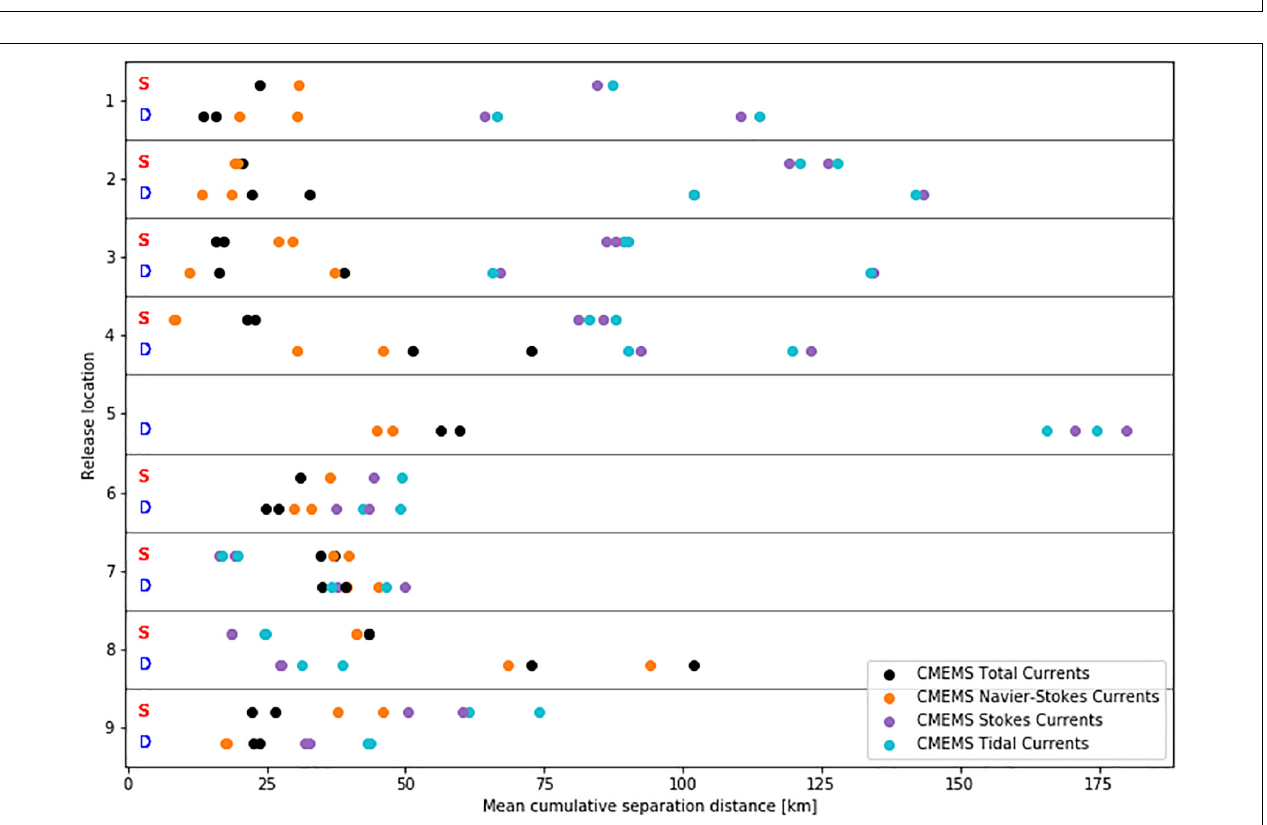
FIGURE 7 | Comparison of observed Stokes and SVP drifters with virtual surface particles computed from the Surface and Merged Ocean Currents (SMOC) product from the Copernicus Marine Environmental Service (CMEMS). Panels (A–I) show results for easternmost location (A) to westernmost location (I) .